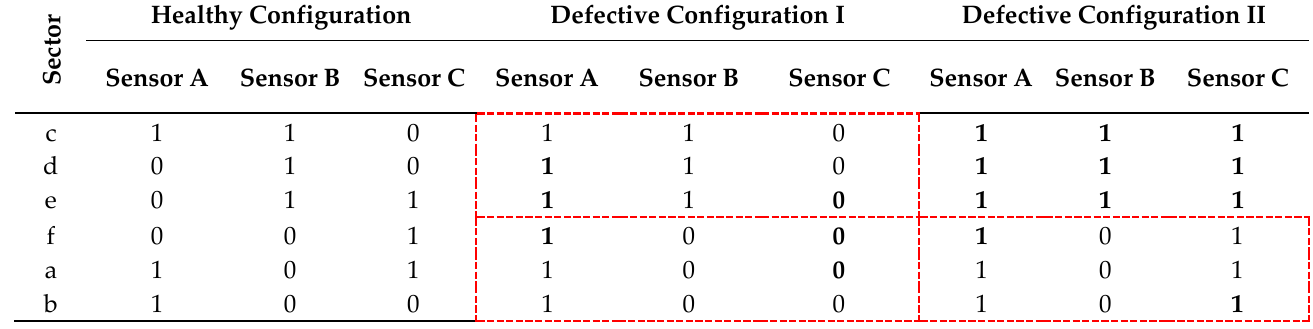
Table 5. The healthy commutation sequence compared to a double breakdown fault of position sensor A at high state and sensor C at different states.